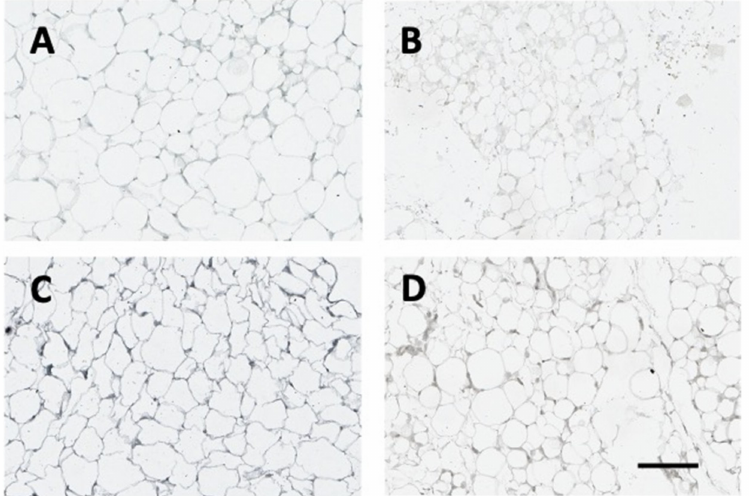
Figure 7. Representative images of adipose tissue from animals in the four groups. Tissue sections were subjected to leptin immunohistochemistry according to established protocols and scanned using an Aperio Digital slide scanner. Panel ( A ): Citrate + GFPvv; Panel ( B ): STZ + GFPvv, Panel ( C ): Citrate + Lepvv; Panel ( D ): STZ + Lepvv. Note the marked increase in leptin expression in the Lepvv group treated with citrate. Scale bar represents 200 µ